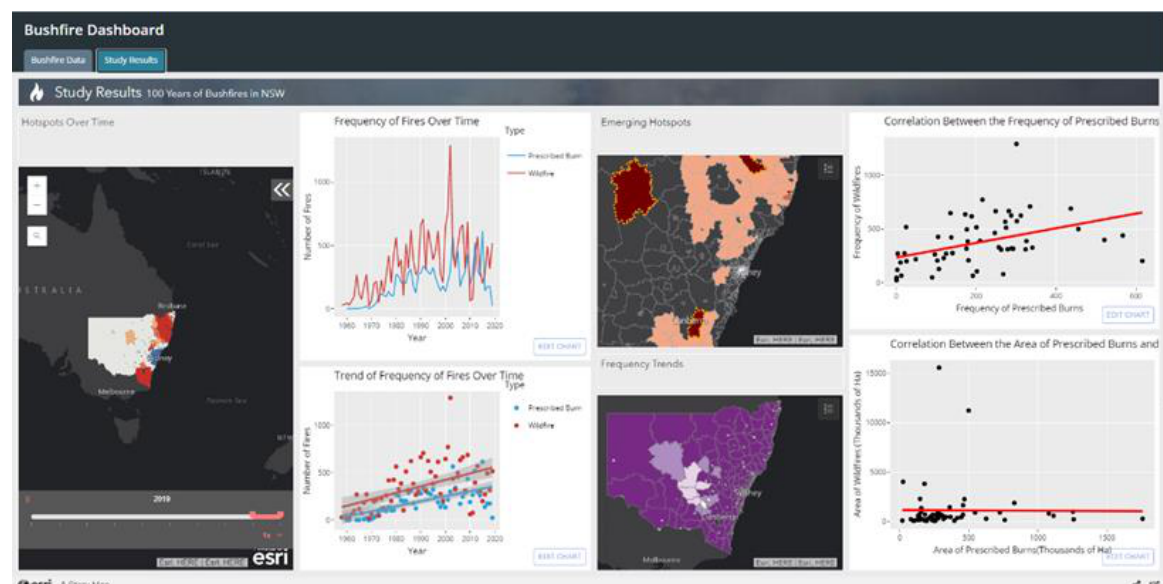
Figure 18. Snippet from the bushfire dashboard.